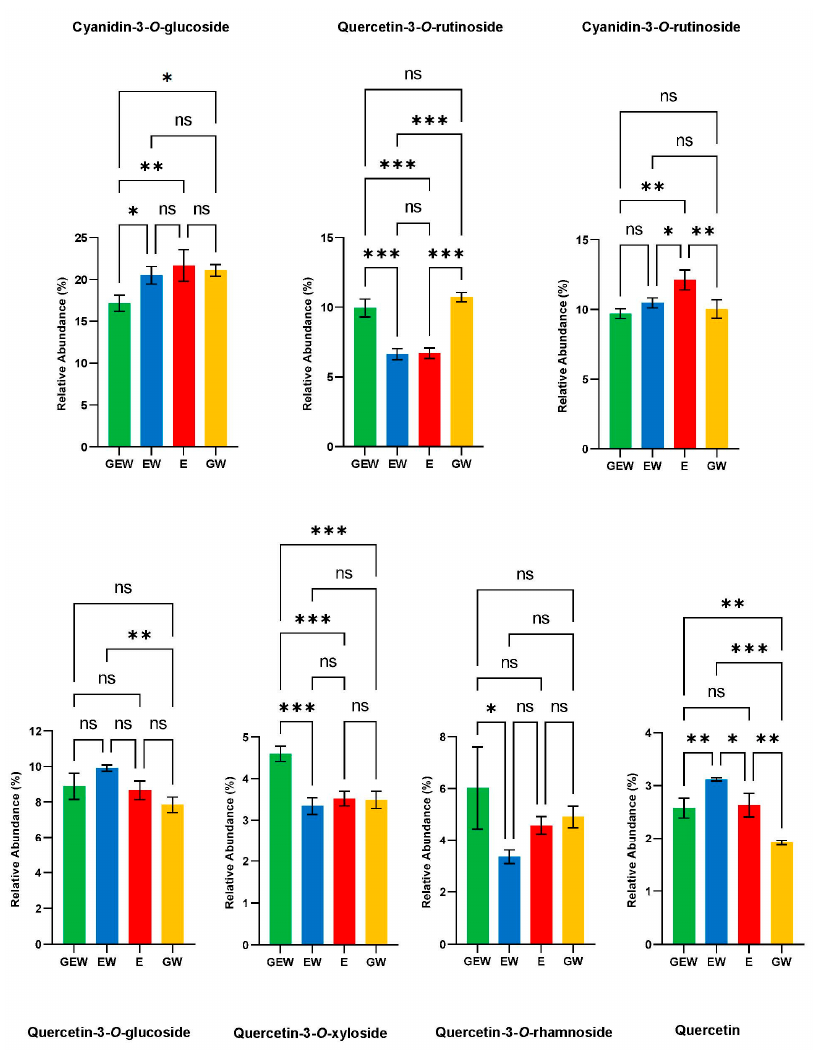
Figure 4. Relative abundance of major polyphenols in Queen Garnet Plum extracts. E = ethanol, EW = ethanol/water, GEW = glycerol/ethanol/water, and GW = glycerol/water. Data are expressed as relative abundance peak area (%) of a metabolite relative to the total peak area of all detected polyphenols ( n = 284). Samples are expressed as the average of replicates ( n = 3) and standard deviation is expressed as error bars on the bar graph. Post-hoc analysis between individual groups using Tukey (p = 0.05) is displayed above each bar graph. P value style: >0.12 (ns), <0.033 (*), <0.002 (**), and <0.001 (***).